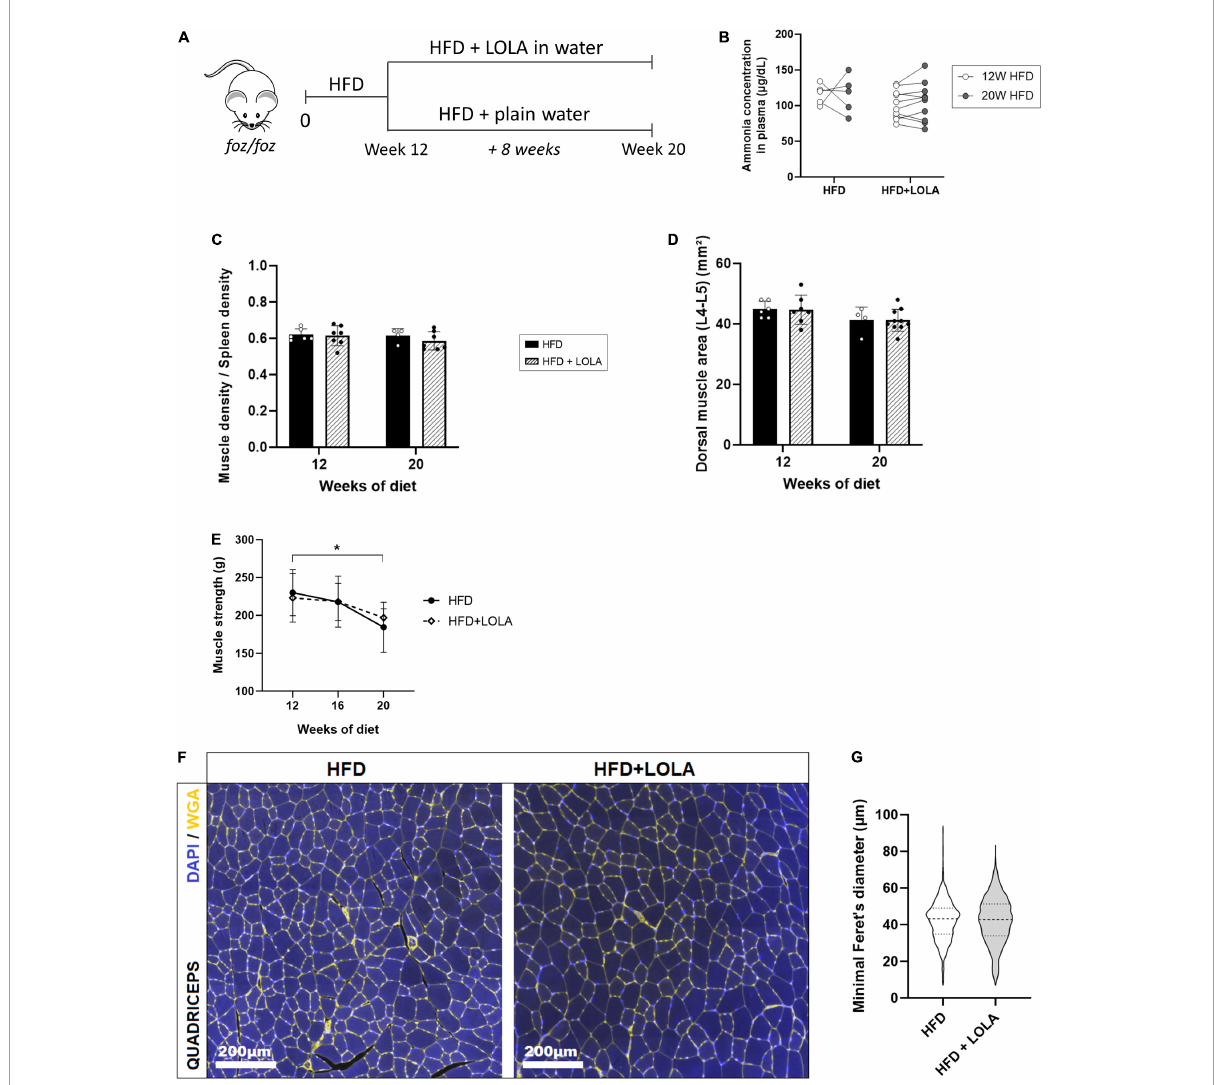
FIGURE5 L-Ornithine L-Aspartate (LOLA) does not reverse myosteatosis in late-stage NASH. (A) LOLA was administered in drinking water to HFD-fed FOZ mice (HFD + LOLA) for the last 8 weeks of the 20-weeks dietary experiment. Treated mice were compared with FOZ HFD given plain water (HFD). (B) Plasma ammonia concentrations measured in systemic blood from HFD and HFD + LOLA after 20 weeks of diet ( n = 5–10); (C) Dorsal muscle-to-spleen density measured in vivo by micro-CT in HFD and HFD + LOLA ( n = 5–10); (D) Dorsal muscle area (L4–L5 averaged) measured in vivo by micro-CT in HFD and HFD + LOLA ( n = 5–10); (E) 4-limb grip strength measured in HFD and HFD + LOLA ( n = 5–10); (F) Wheat-germ agglutinin (WGA) staining of myofibers performed on paraffin-embedded quadriceps sections; (G) Quantification of myofibers size performed on quadriceps WGA-stained sections ( n = 5–10). All data are represented as mean ± SD, * p < 0.05. Statistical tests used: (G) Unpaired two-tailed t -test. (B–E) Repeated-measures two-way ANOVA followed by post hoc Bonferroni